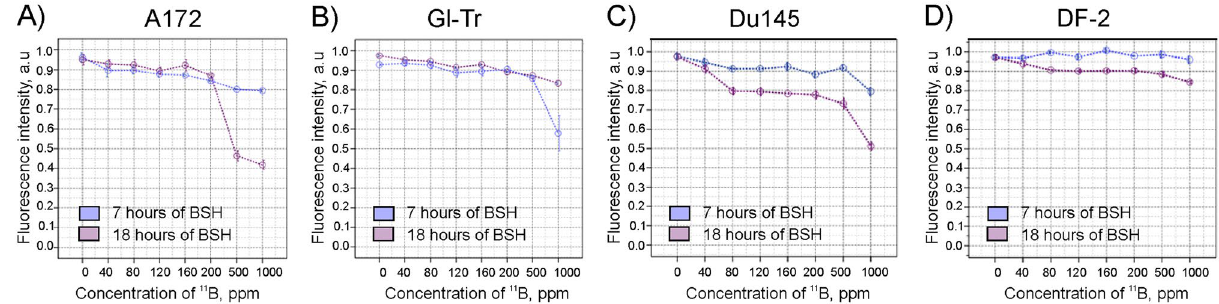
Figure 1. Cytotoxicity of sodium borocaptate (BSH) for A172 ( A ), Gl-Tr ( B ) glioma cells, Du145 prostate cancer cells ( C ), and DF-2 fibroblasts of human skin ( D ). The cytotoxic effects of BSH at 0—1000 ppm of 11 B concentration have been studied by the AlamarBlue cell viability assay after 7 h or 18 h of